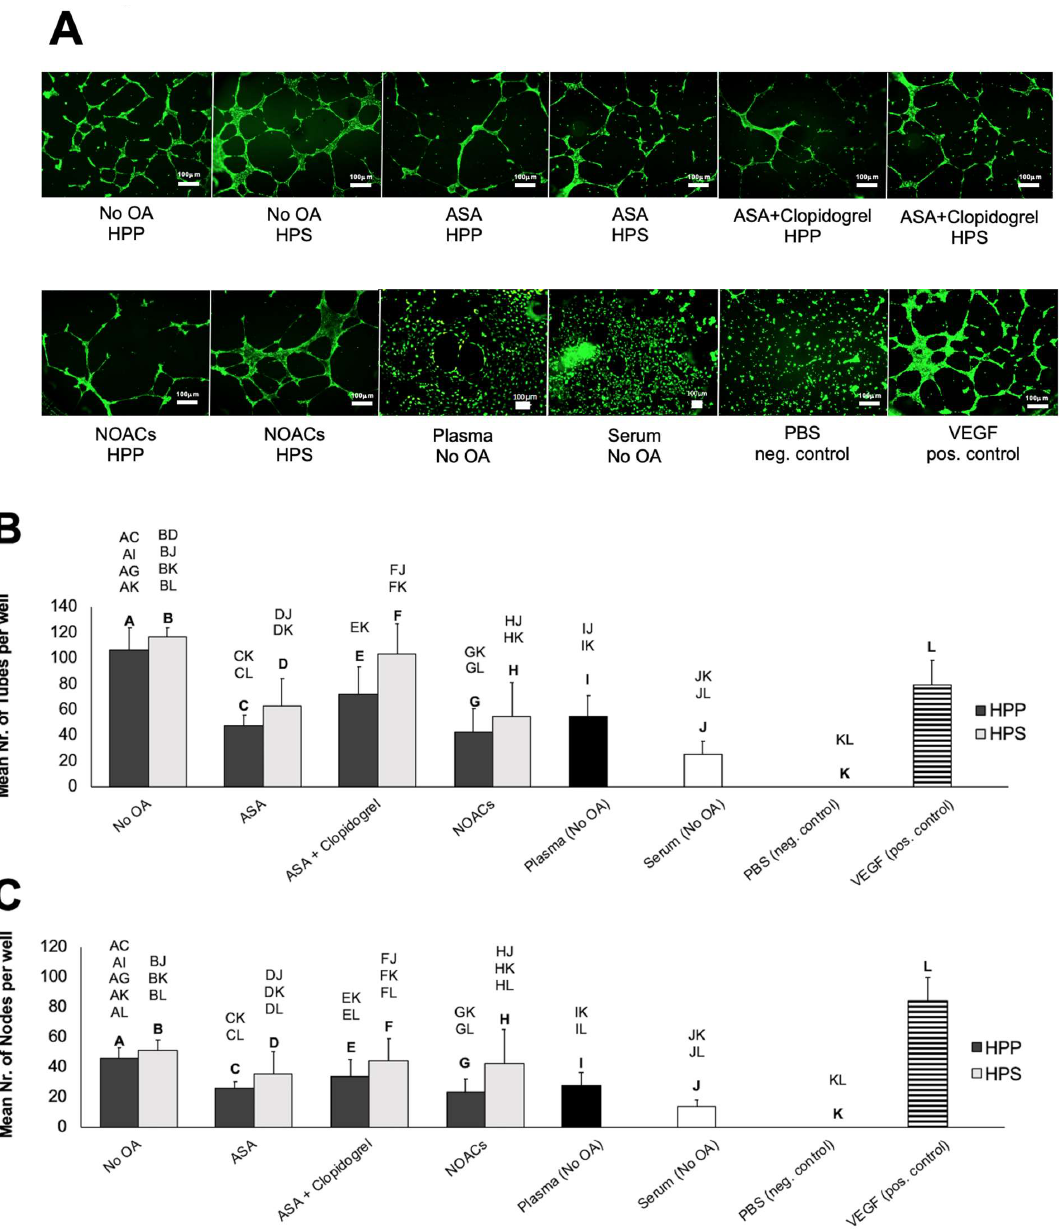
Figure 5. E ff ects of hypoxia preconditioned blood-derived secretomes obtained with or without oral anticoagulation (OA) on microvessel formations in human umbilical vein endothelial cell (HUVEC) cultures in vitro. ( A ) Panel showing representative images of the tube formation assay (12 h) carried out in the presence of blood-derived secretomes (HPP, HPS, normal plasma, and normal serum) obtained from subjects that did not receive oral anticoagulation (OA) or were treated with acetylsalicylic acid (ASA), ASA + clopidogrel, or nonvitamin K antagonist oral anticoagulants (NOACs) (Bars = 100 µ m). ( B ) Plots showing the mean number of tubes and ( C ) nodes formed in HUVEC cultures that were incubated for 12 h with blood-derived secretomes. Capital letter pairs over plots indicate statistical comparisons of the corresponding data points. For all pair comparisons, p < 0.05, unless otherwise indicated. Error bars represent s.d.; number of subjects tested: no OA, n = 5; ASA, n = 8; ASA + clopidogrel, n = 10; NOACs, n = 7; normal plasma (no OA), n = 5; normal serum (no OA), n = 5; phosphate-bu ff ered saline (PBS), n = 3; and VEGF, n = 3. Three samples were tested per subject per